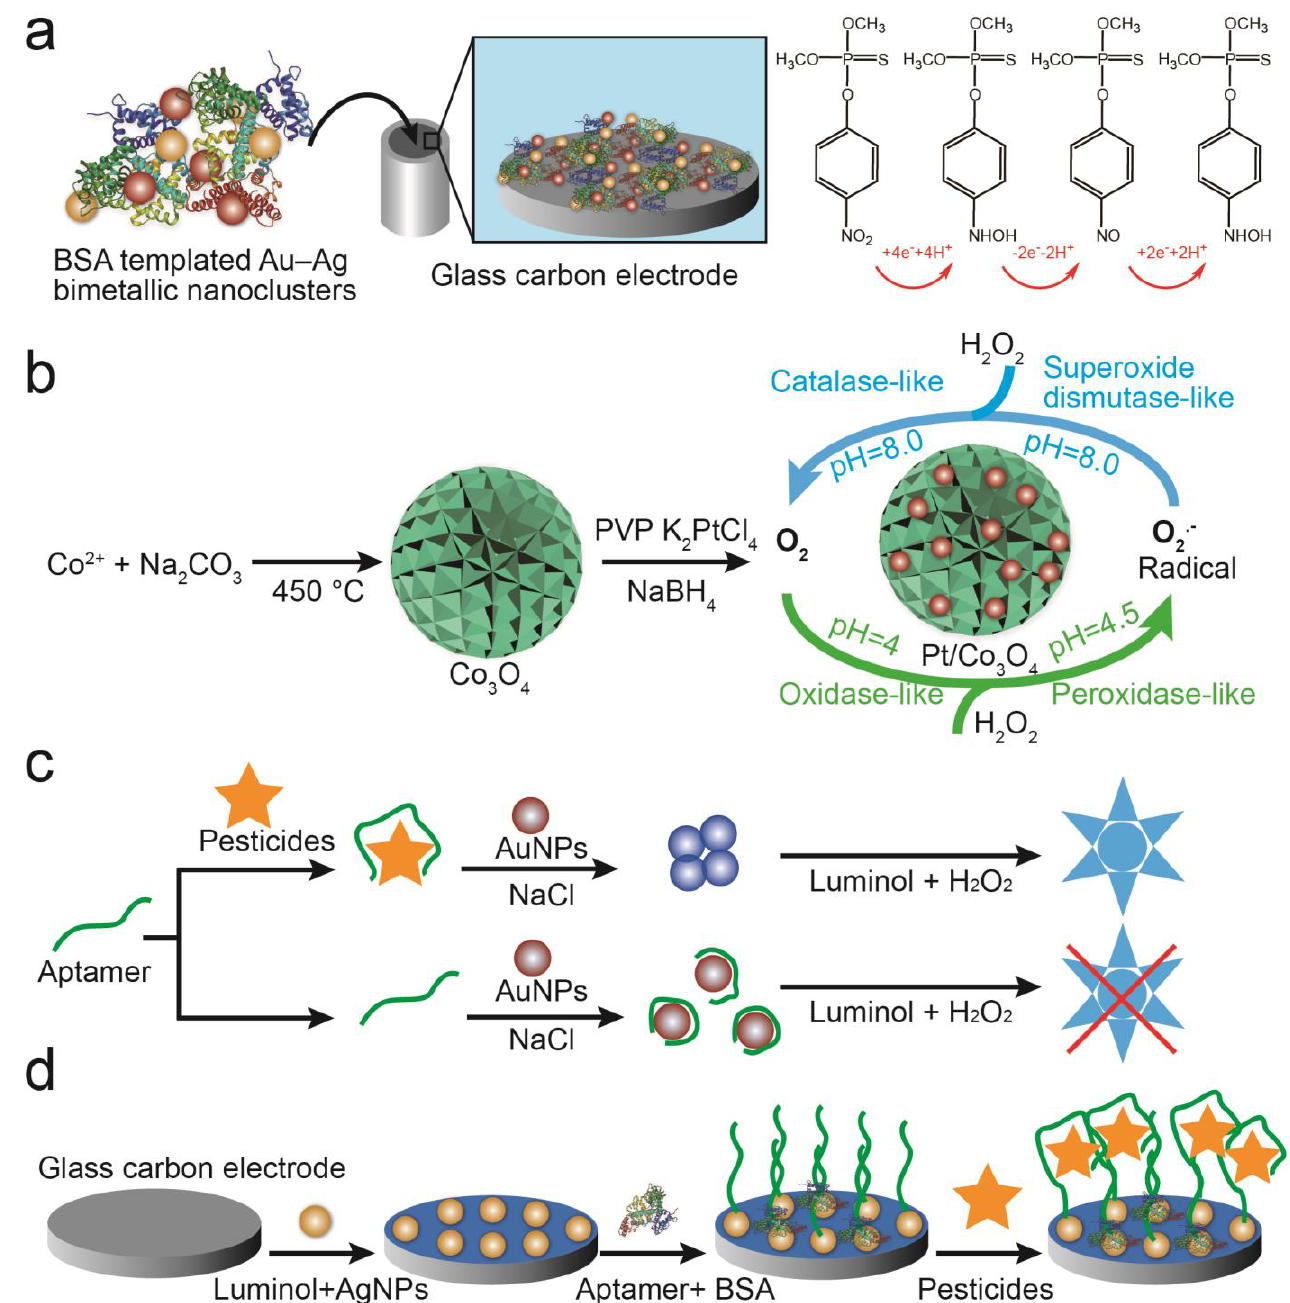
Figure 5. Detection of pesticides using nanoparticle catalytic properties. ( a ) Using AuNPs and MWCNTs-CeO 2 -modified electrodes to catalyze redox reactions of methyl parathion [46]. ( b ) A mul- tifunctional colorimetric detection platform using Pt/Co 3 O 4 to detect thiram [52]. ( c ) An AuNP-based chemiluminescence sensor to detect acetamiprid based on conformational changes in aptamers [53]. ( d ) AgNPs modified with aptamers for detecting atrazine by ECL [54].